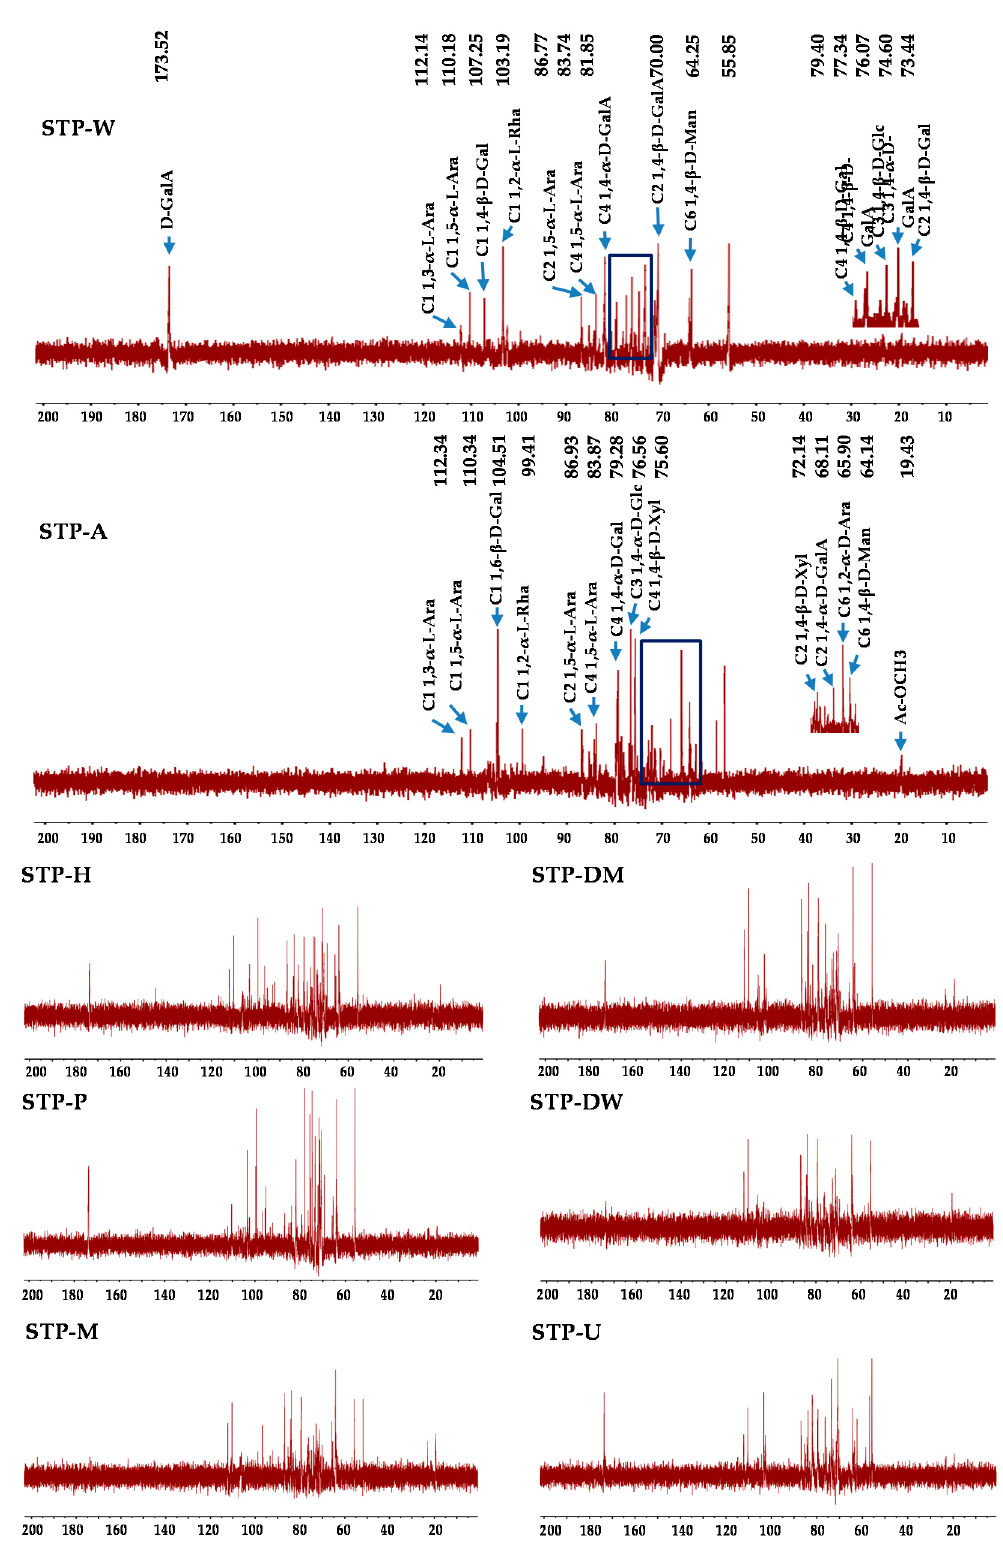
Figure 4. 13 C nmR spectra of STPs. STP-W, STP-M, STP-U, STP-P, STP-H, STP-DW, STP-DM, and STP-A indicate sweet tea polysaccharides extracted by hot water extraction, microwave-assisted extraction, ultrasound-microwave-assisted extraction, pressurized water extraction, high-speed shearing homogenization extraction, deep eutectic solvent-assisted extraction, deep eutectic solvent-microwave-assisted extraction, and alkali-assisted extraction,